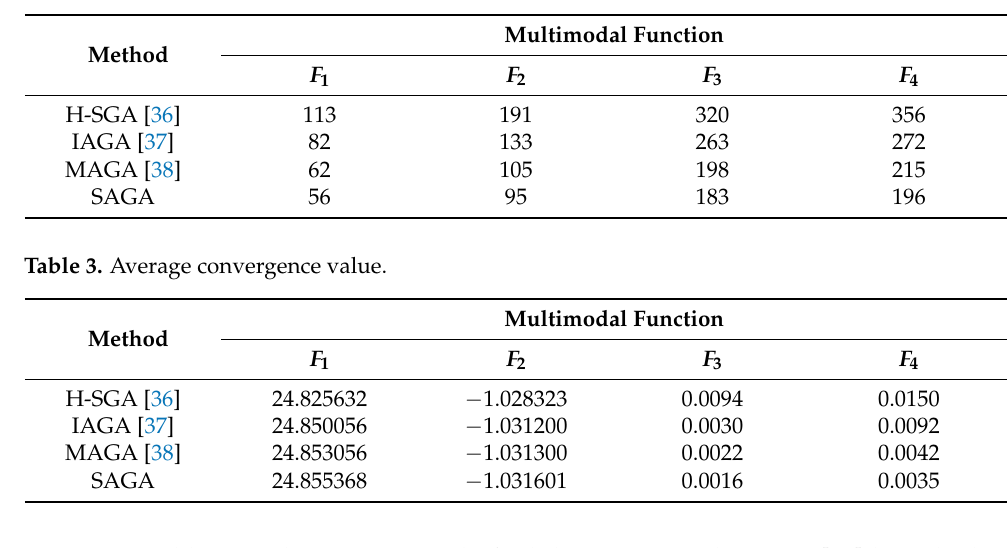
Table 2. Average convergence generation.